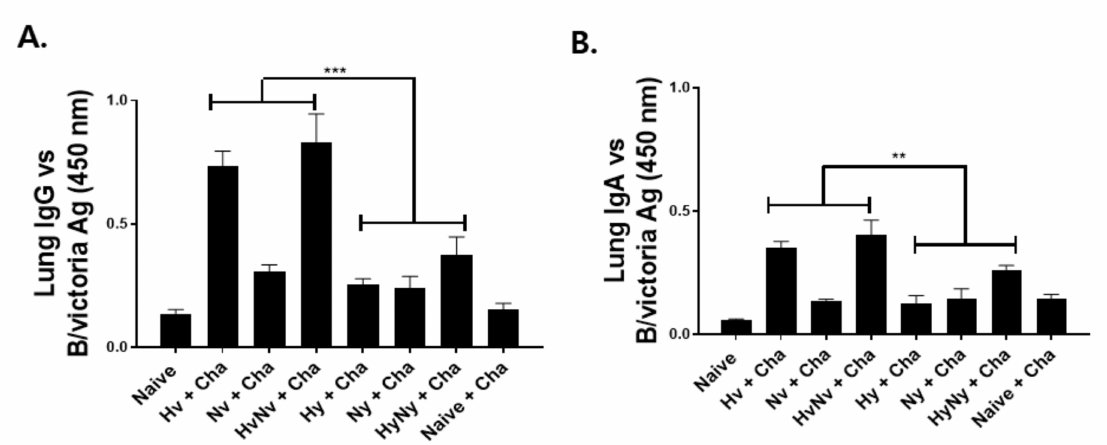
Figure 3. Antibody responses in the lung. Immunized mice were intranasally infected with a lethal dose of B/Colorado/06/2017 at 4 weeks after boost immunization. Lungs from individual mice were collected at 4 dpi to evaluate pulmonary IgG ( A ) and IgA ( B ) antibody responses by ELISA. Naïve+Cha refers to those naïve mice who were challenge infected with a lethal dose of influenza virus. Data are expressed as mean ± SD with asterisks denoting statistical significance between groups (** p < 0.01, *** p < 0.001).